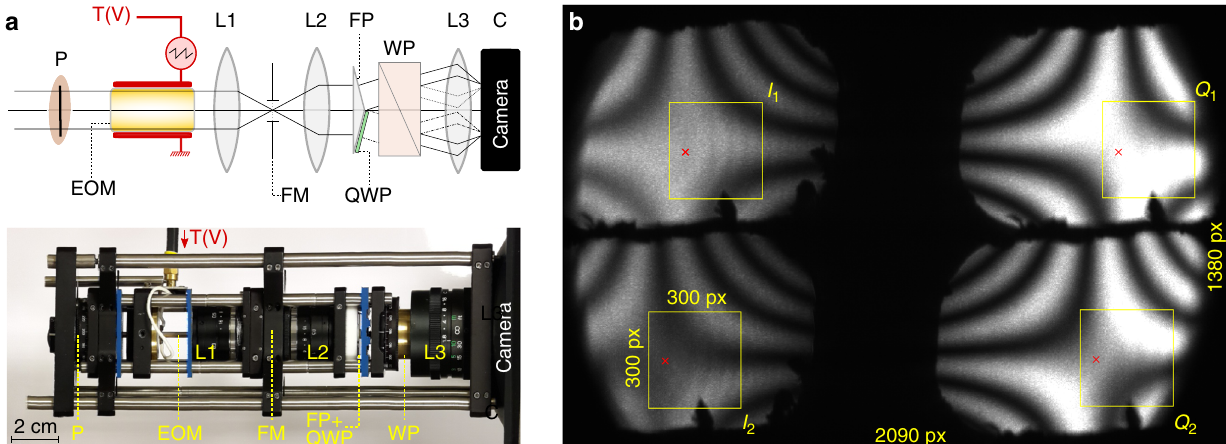
¼ 5 kHz or f ¼ 5 : 01 kHz. Right: Modulation d d is set to the d